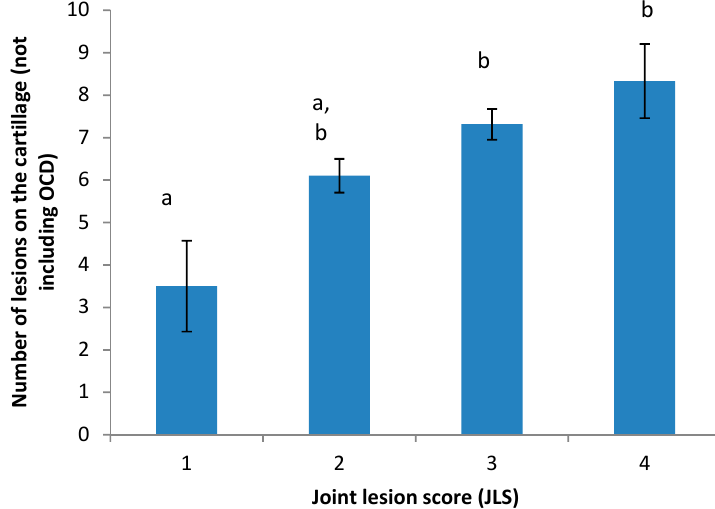
Figure 3. Comparison of the number of lesions on the joint cartillage relative to the overall joint lesion score (JLS) assigned. Levels of the JLS were 1 = normal, 2 = mild abnormality, 3 = moderate abnormality and 4 = severe abnormalitya, b indicates a significant difference in the number of lesions present, between JLS categories.